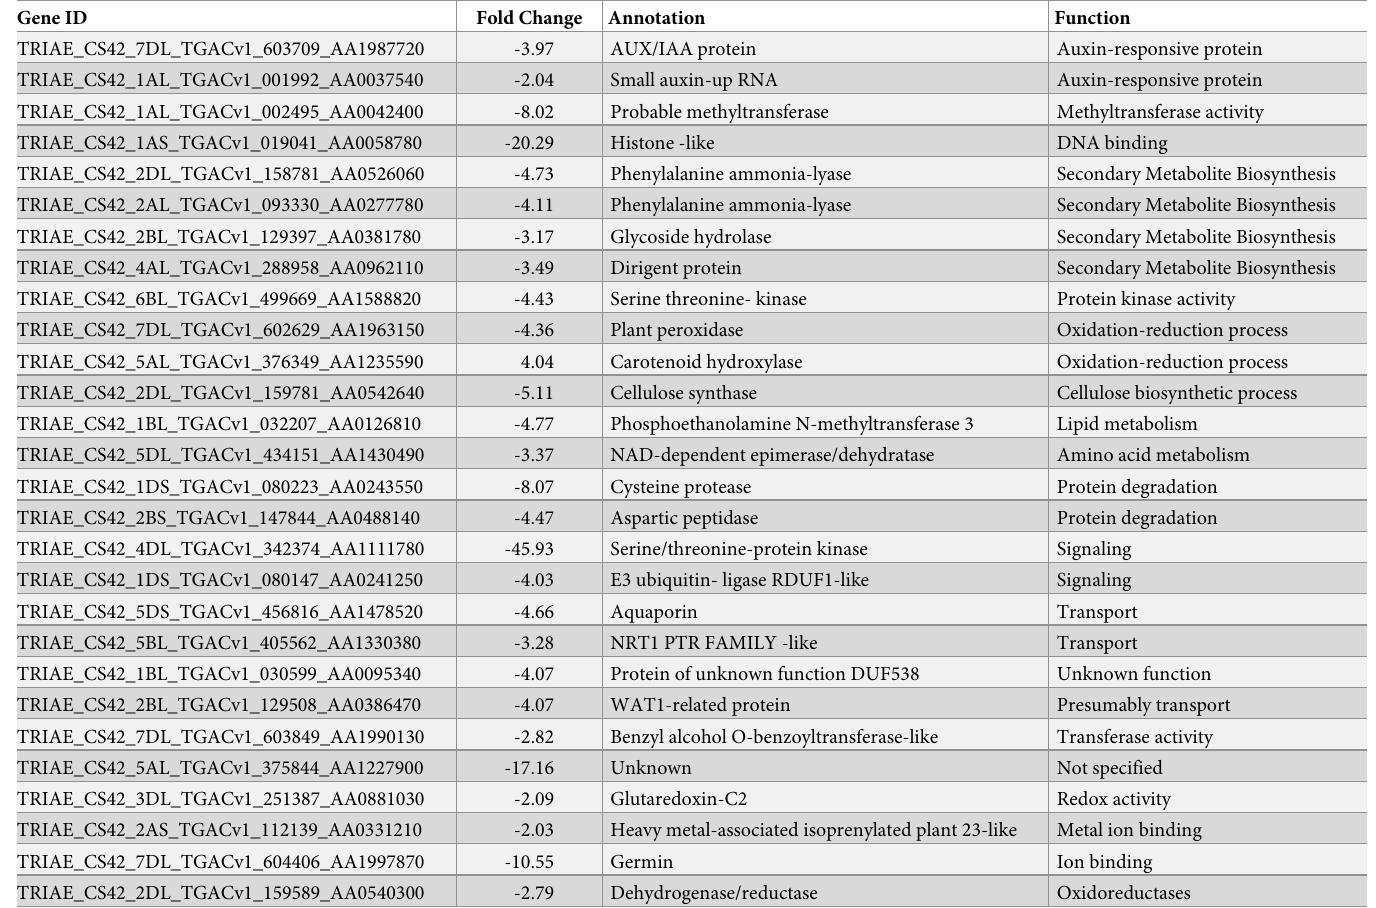
Table 3. List of specific genes which are significantly down-regulated in ED vs. EN. Gene